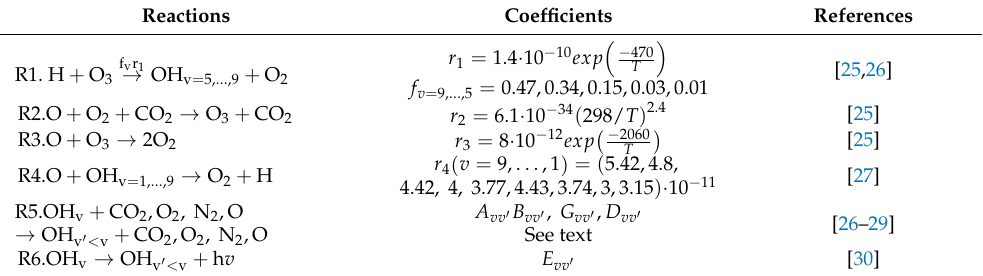
Table 1. List of reactions, nomenclature of reaction rates, quenching coefficients, and spontaneous emission coefficients used in the